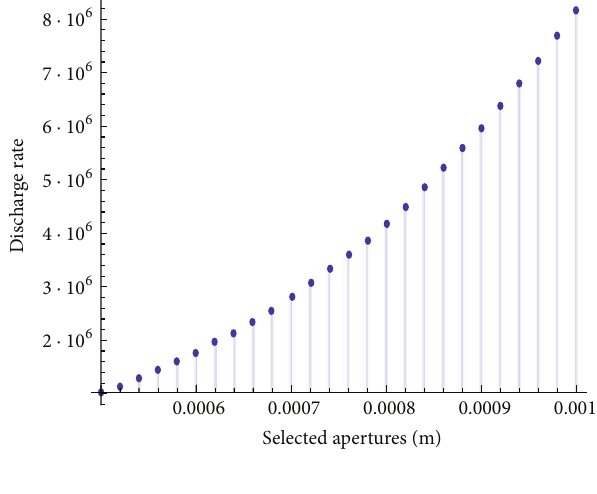
Figure 12: Cumulative distribution function for selected transmis- sivity (m 2